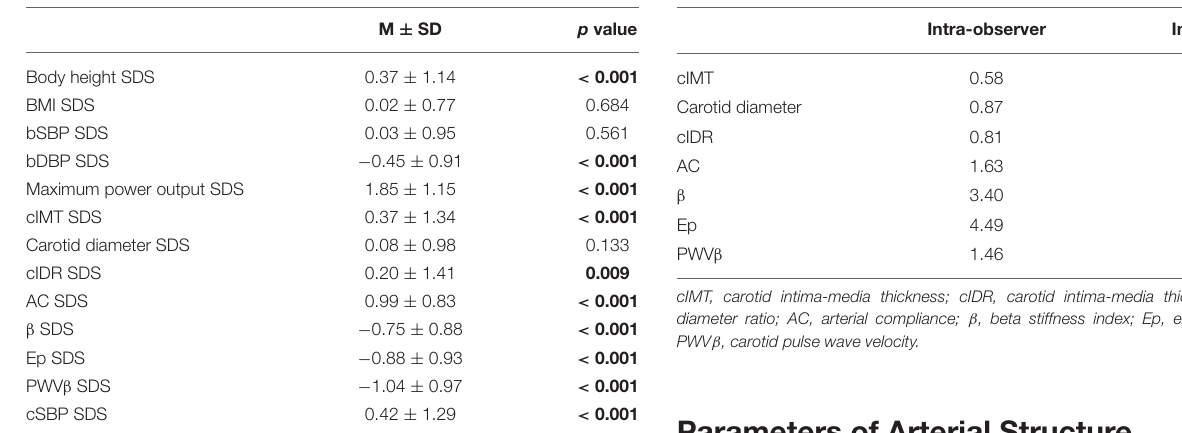
TABLE 2 | SDS values of parameters of body height, BMI, blood pressure, physical performance and vascular properties.